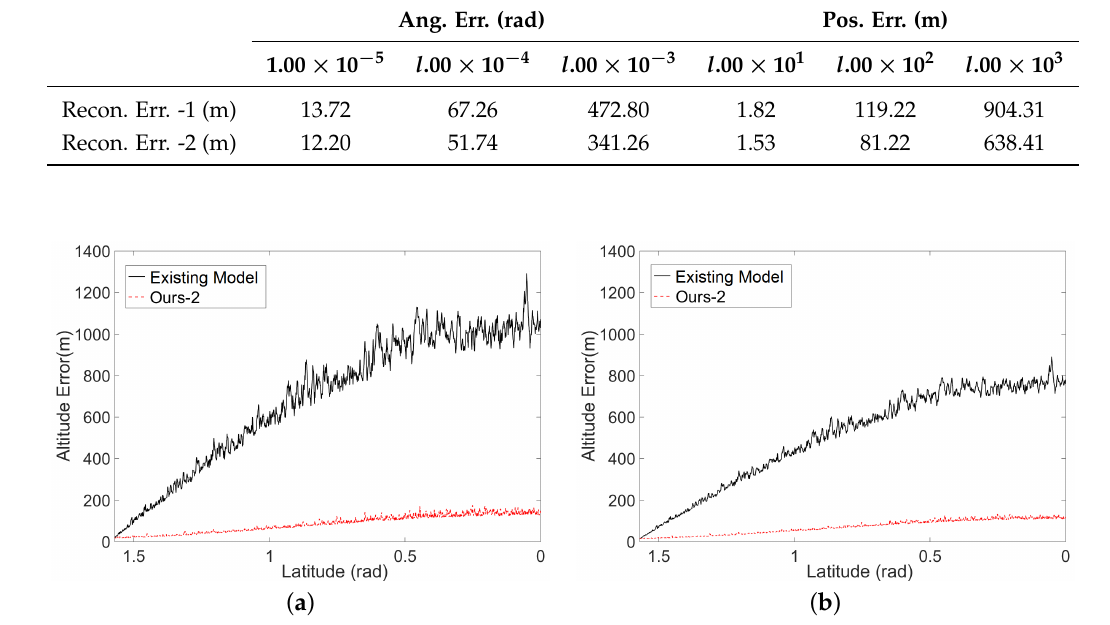
Figure 9. Errors of the reconstructed altitude values for pixels on the simulated images covering the areas from the pole ( π /2 latitude) to the Equator (0 latitude). The errors of the reconstructed altitude values on the same latitude are averaged. The red and black curves indicate the reconstructed error based on our estimated EOPs and the estimated EOPs by the existing model, respectively. ( a ) The reconstructed errors based on the simulated data for Chang’E-1; ( b ) the reconstructed errors based on the simulated data for